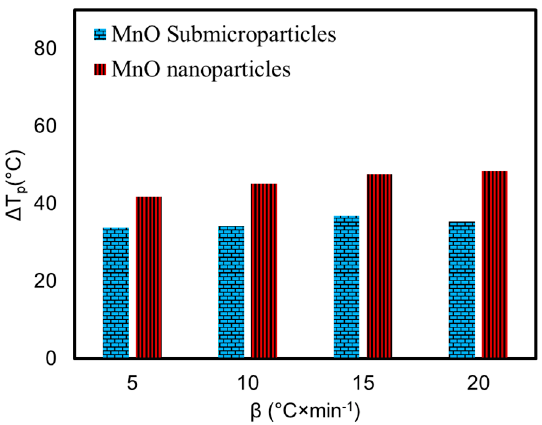
Figure 9. Differences between peak temperatures ( Δ Tp) for heavy oil oxidation at different heating rates in the presence of MnO particles with different sizes and shapes.